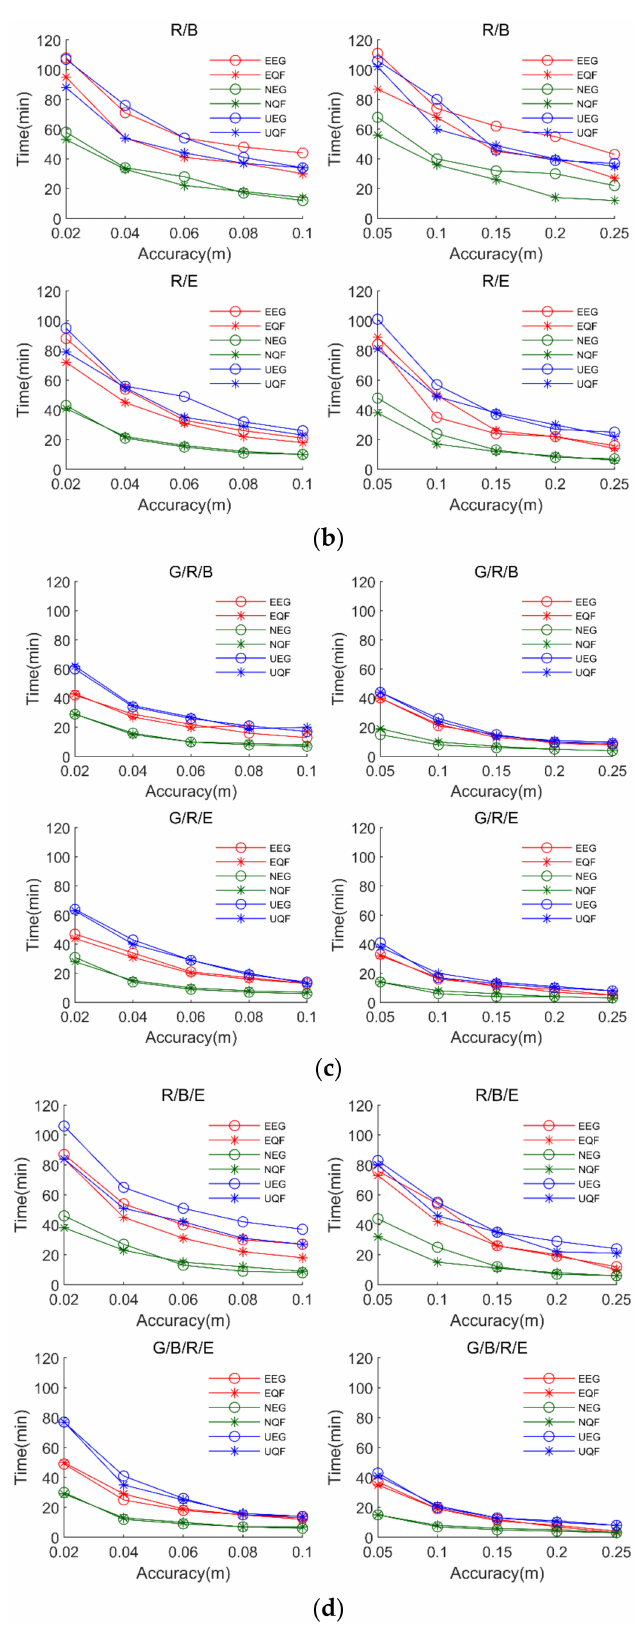
Figure 11. The corresponding time when 68% of the total stations reach the convergence accuracy in three directions. The figure includes four parts ( a – d ), and each part includes four subplots. The left column of each part shows the convergence times of the two IFCB models in static mode with